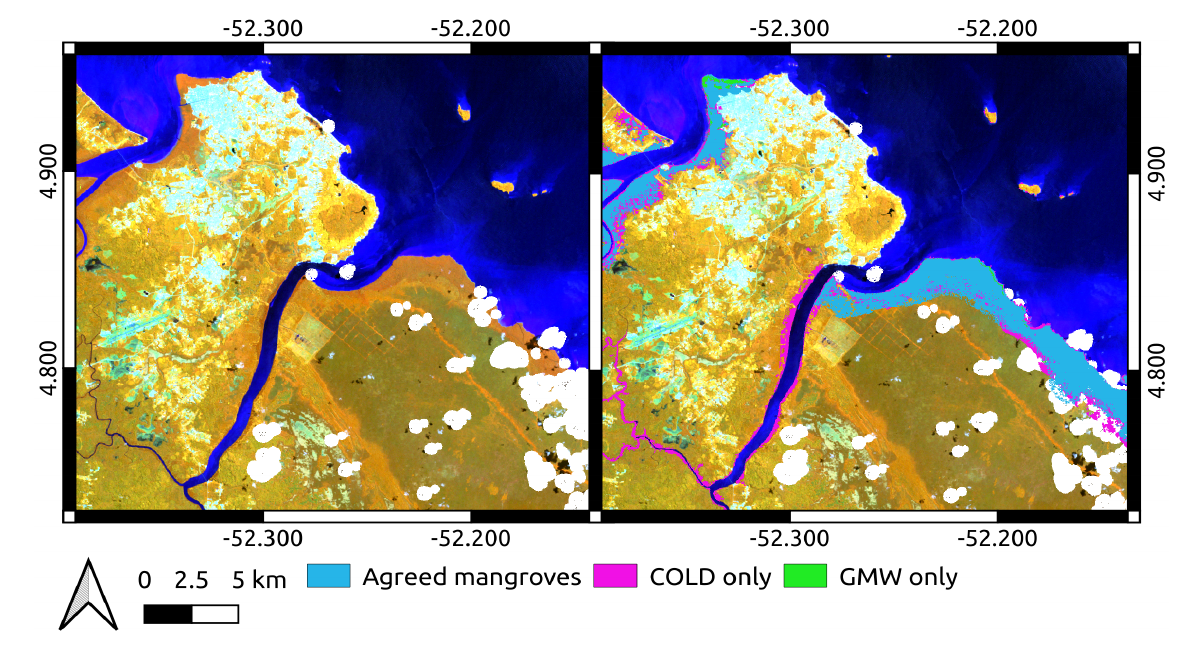
Figure 6. Example classification of mangroves for the French Guiana site. Left: false colour Landsat 5 image from July 2010 where Red = NIR, Green = SWIR1, and Blue = Red. Right: mangrove extent as estimated by the two classifiers. Mangroves in this region are spectrally difficult to distinguish from other tropical